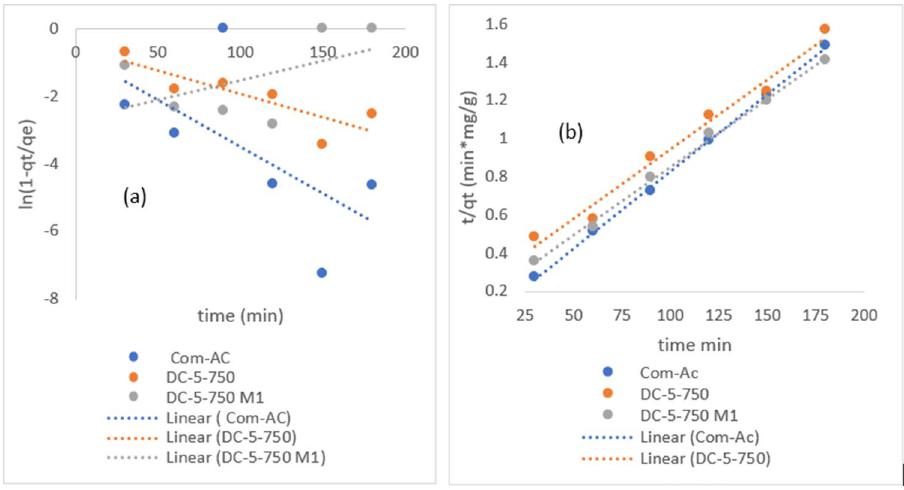
Figure 19. MR PFO ( a ) and PSO ( b ) kinetic model.